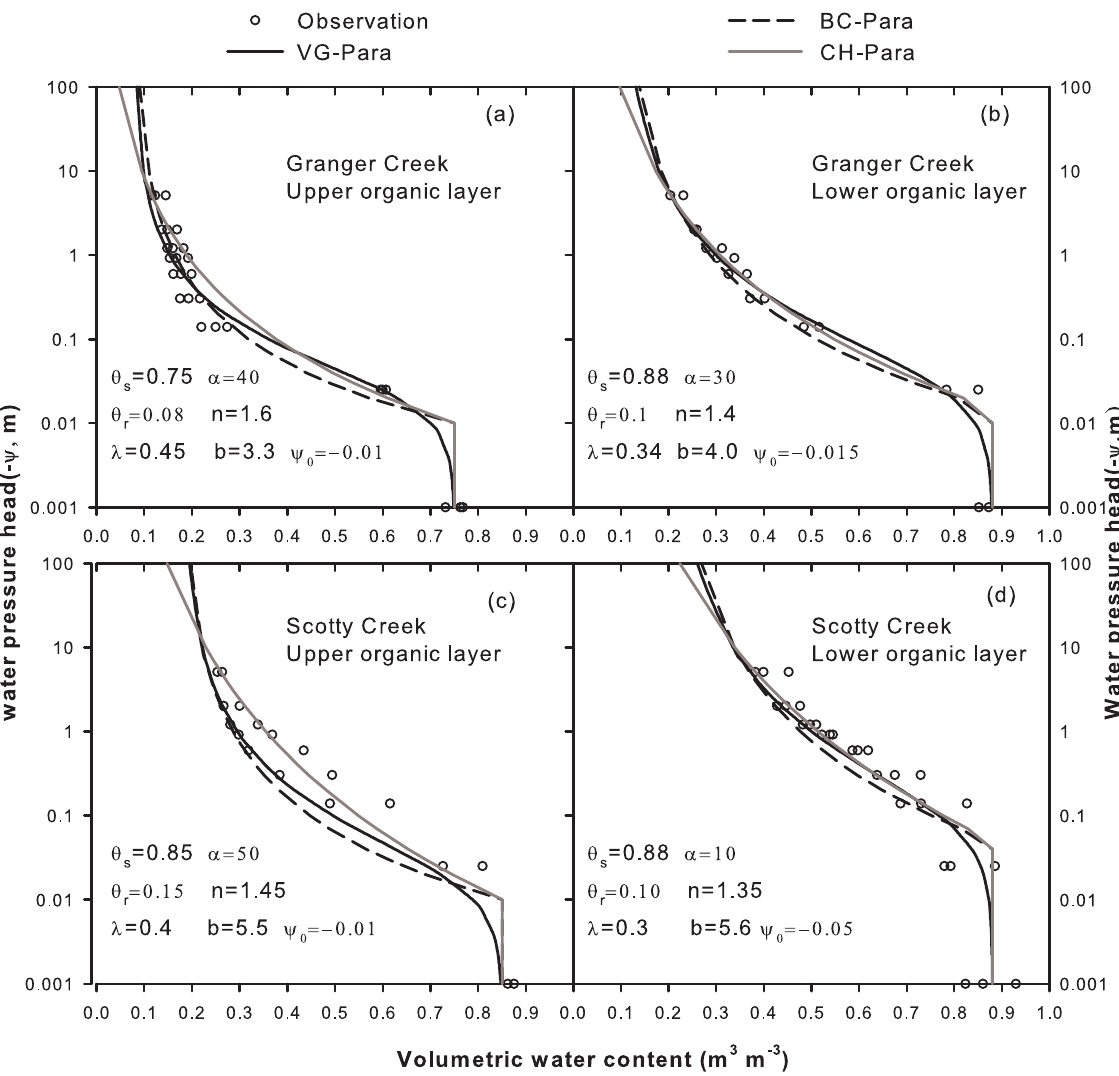
Fig. 1. Measured soil water content–pressure head relationships and best fitting curves with three parameterisation methods for several organic soils at a peat plateau of Scotty Creek and a north-facing slope of Grange